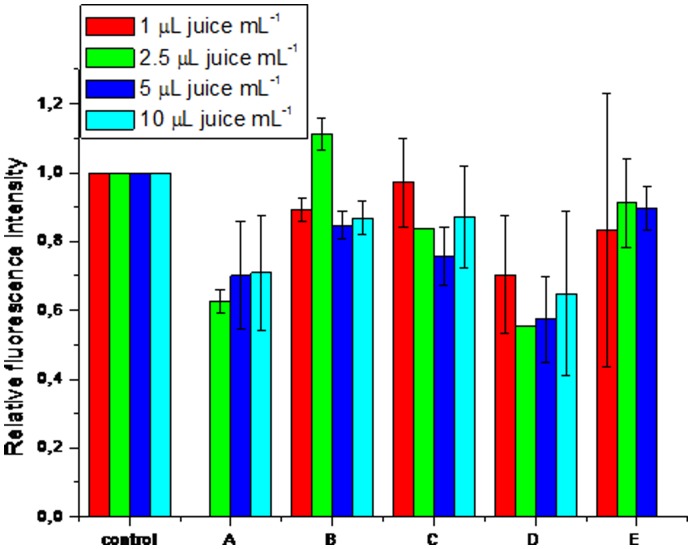
Intracellular oxidation in the yeast S. cerevisiae after 2-h exposure to different berry juices at different concentrations.